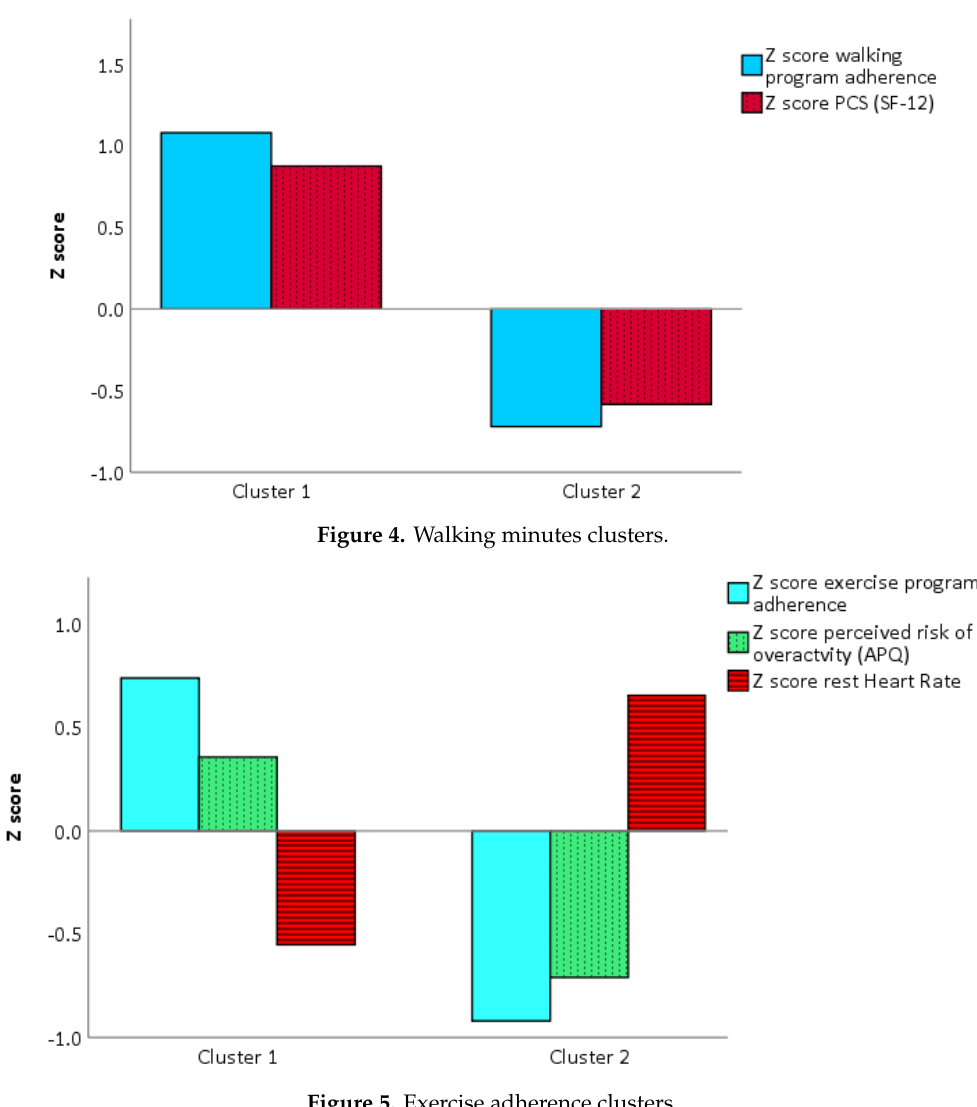
Figure 5. Exercise adherence clusters.